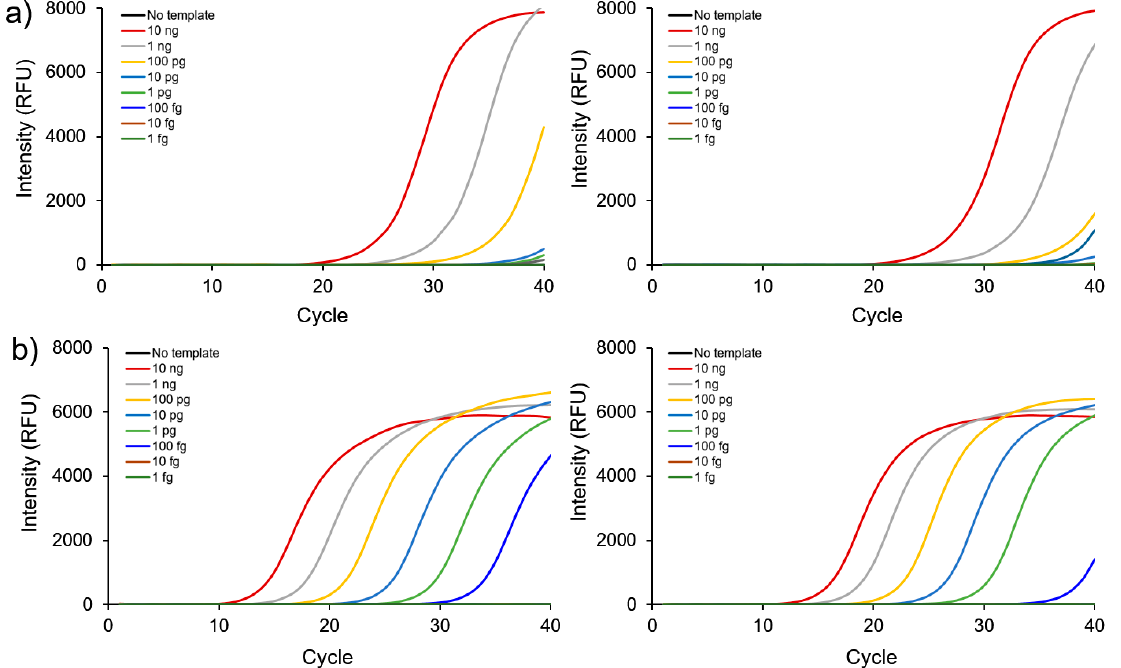
Figure 3. Effect of FMDV gene concentrations on nano-PCR using pan-type primers. Quantitation of FMDV gene amplification without ( a ) and with ( b ) GO-AuNPs. Left and right panels, O- and A-type genes, respectively.